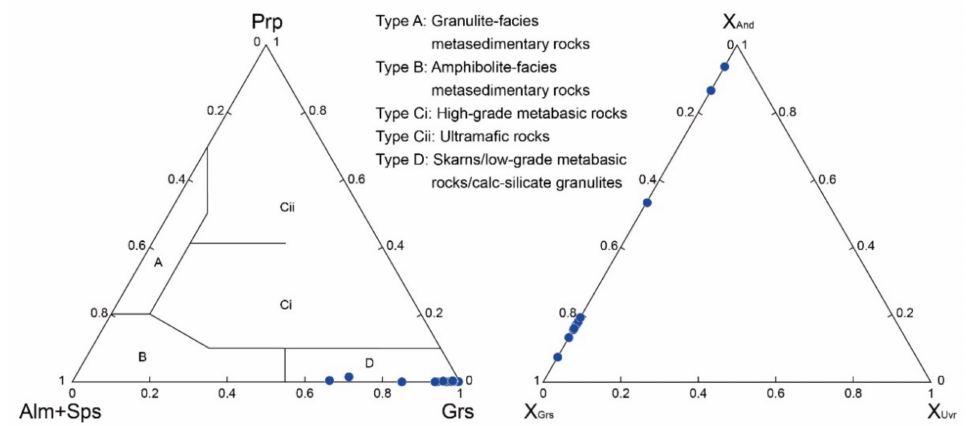
Figure 6. Garnet classification scheme of [18] (left) and X And –X Grs –X Uvr ternary diagram (right).